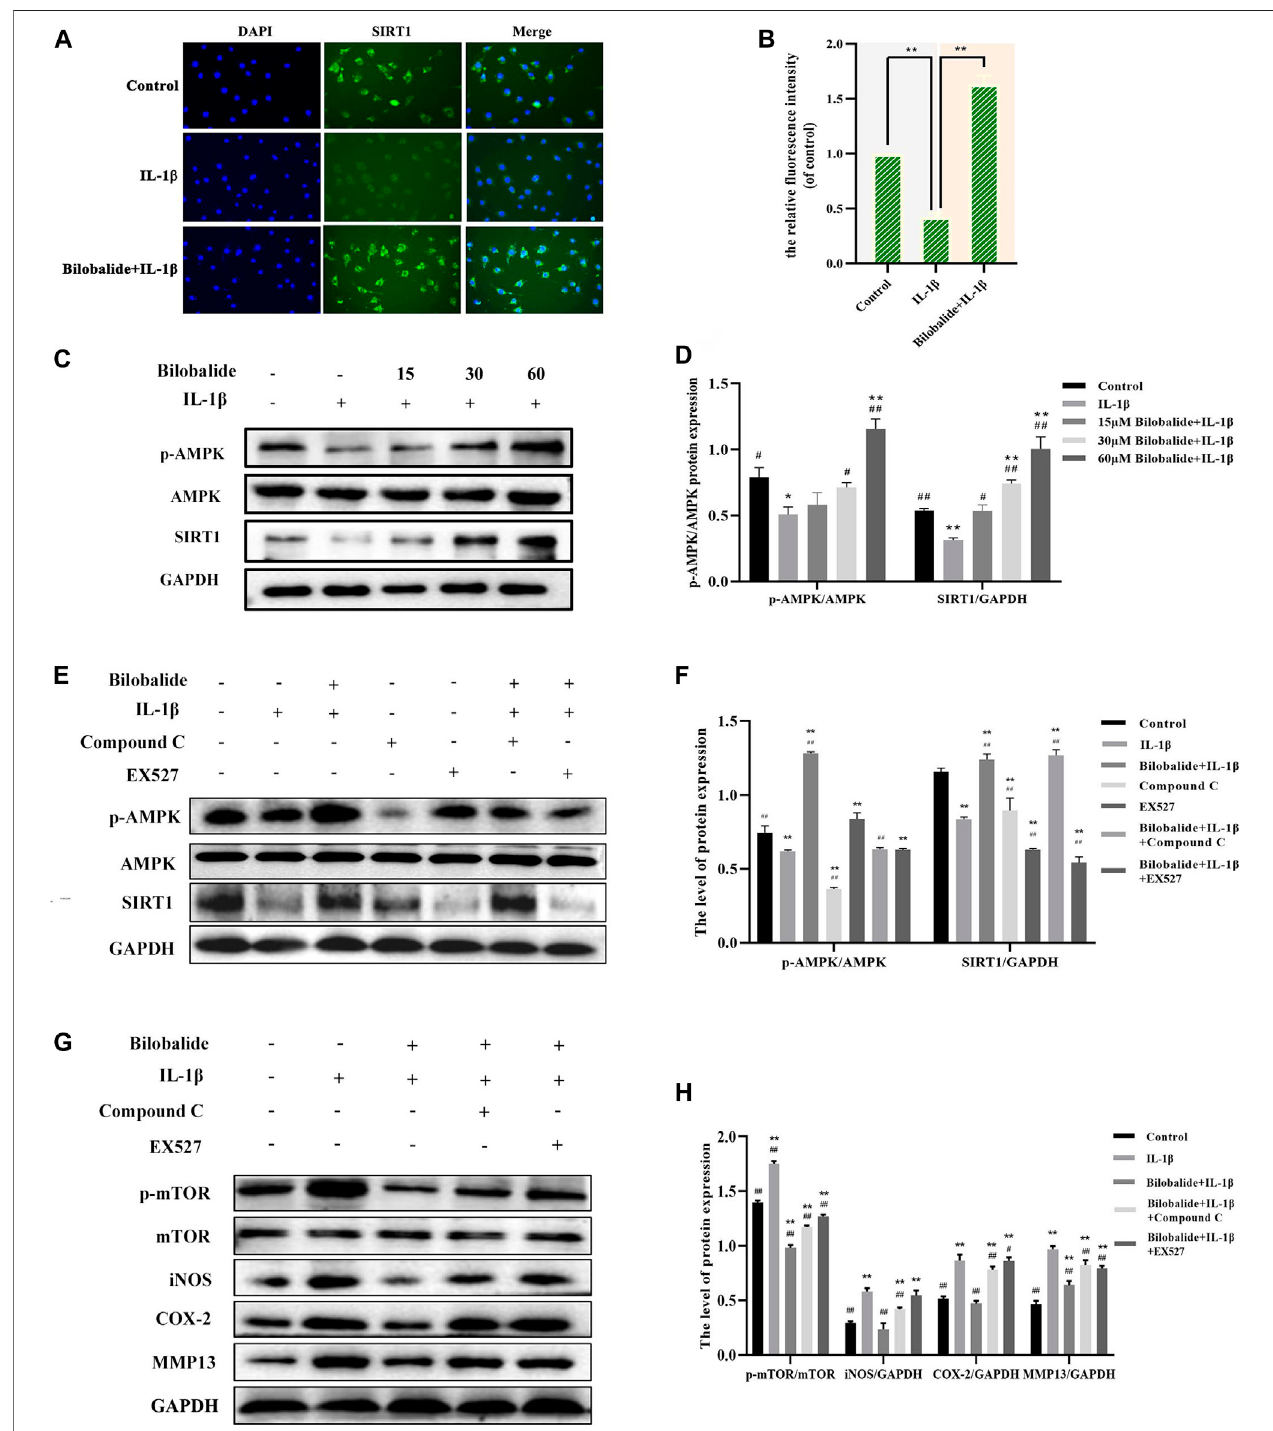
FIGURE5| TheeffectofbilobalideontheAMPK/SIRT1/mTORsignalingpathwayinATDC5chondrocytesinducedbyIL-1 β . (A,B) The fl uorescenceintensityofthe Sitr1 protein was detected by immuno fl uorescence. (C,D) Western blot analysis of AMPK, p-AMPK, and SIRT1 protein expression after treating the cells with IL-1 β and different concentrations bilobalide for 24 h (E,F) Western blot analysis of AMPK, p-AMPK, and SIRT1 protein expression after chondrocytes were pretreated with the AMPK inhibitor compound C and the SIRT1 inhibitor EX-527. (G,H) Western blot analysis of mTOR, p-mTOR,iNOS, COX-2, and MMP13 protein expression after the addition of compound C or EX-527. All data were presented as mean ± SD ( n = 3). * p < .05 and ** p < .01 compared to the control group; # p < .05 and ## p < .01 compared to the IL-1 β group (Statistical analysis using one-way ANOVA, two-way ANOVA, paired two-tailed Student ’ s t-test, and unpaired two-tailed Student ’ s t-test).